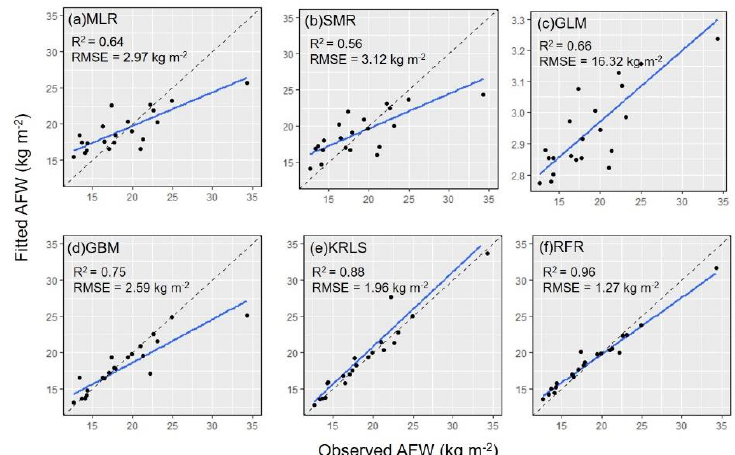
Figure 3. Relationship between observed aboveground fresh weight (AFW) and fitted AFW of sugarcane via the six regression algorithms based on sampling plots. ( a ) multiple linear regression (MLR); ( b ) stepwise multiple regression (SMR); ( c ) generalized linear model (GLM); ( d ) generalized boosted model (GBM); ( e ) kernel-based regularized least squares (KRLS); ( f ) random forest regression (RFR). The black dotted line represents the 1:1 line, and the blue solid line represents a linear fit.